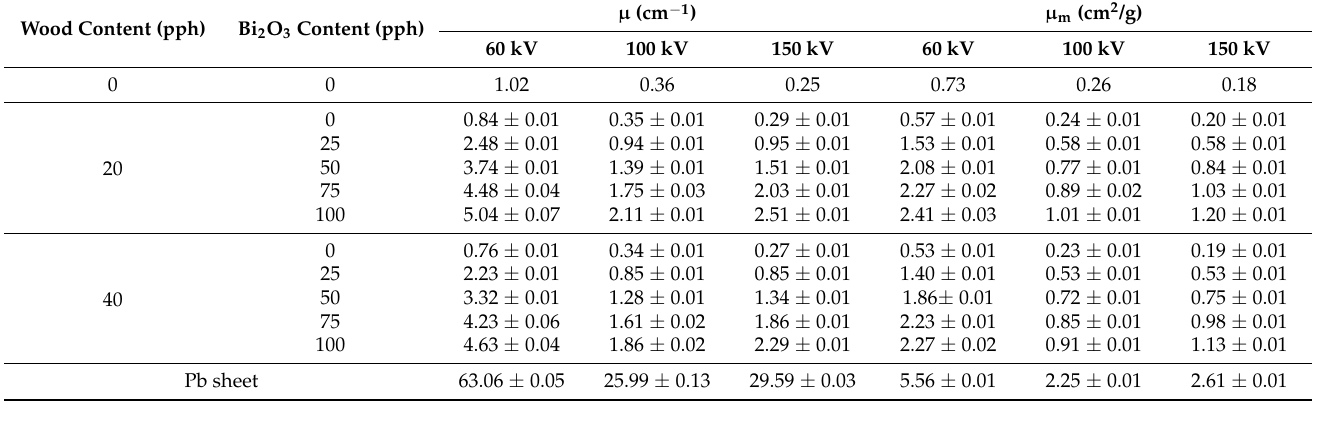
Table 3. X-ray shielding properties, including linear attenuation coefficients (µ) and mass attenuation coefficient (µ m ) of WPVC composites containing 0 – 100 pph of Bi 2 O 3 and 20 – 40 pph of wood particles, Pb sheet, and a neat PVC, determined for X-ray levels of 60, 100, and 150-kV. Results are shown as mean ± standard deviation. Wood Content (pph)